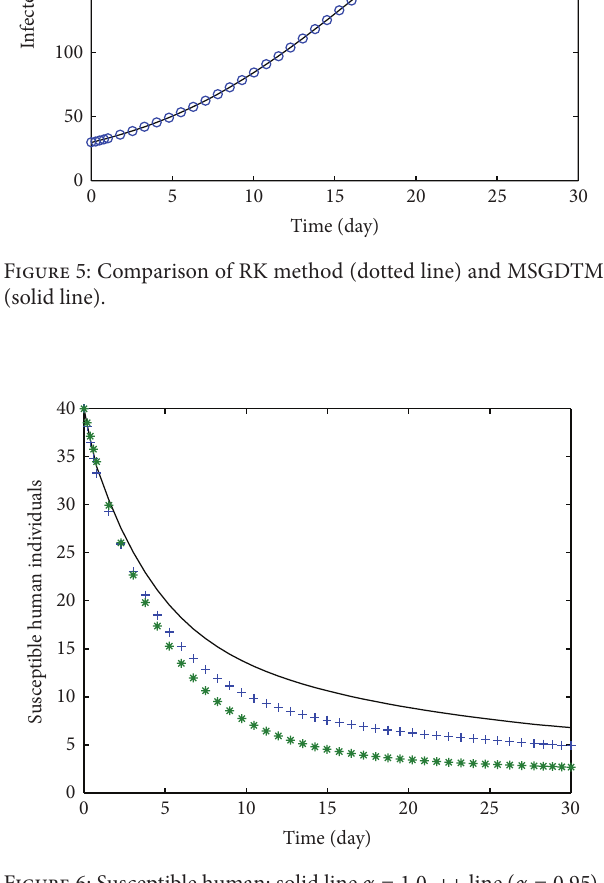
Figure 4: Comparison of RK method (dotted line) and MSGDTM (solid line).